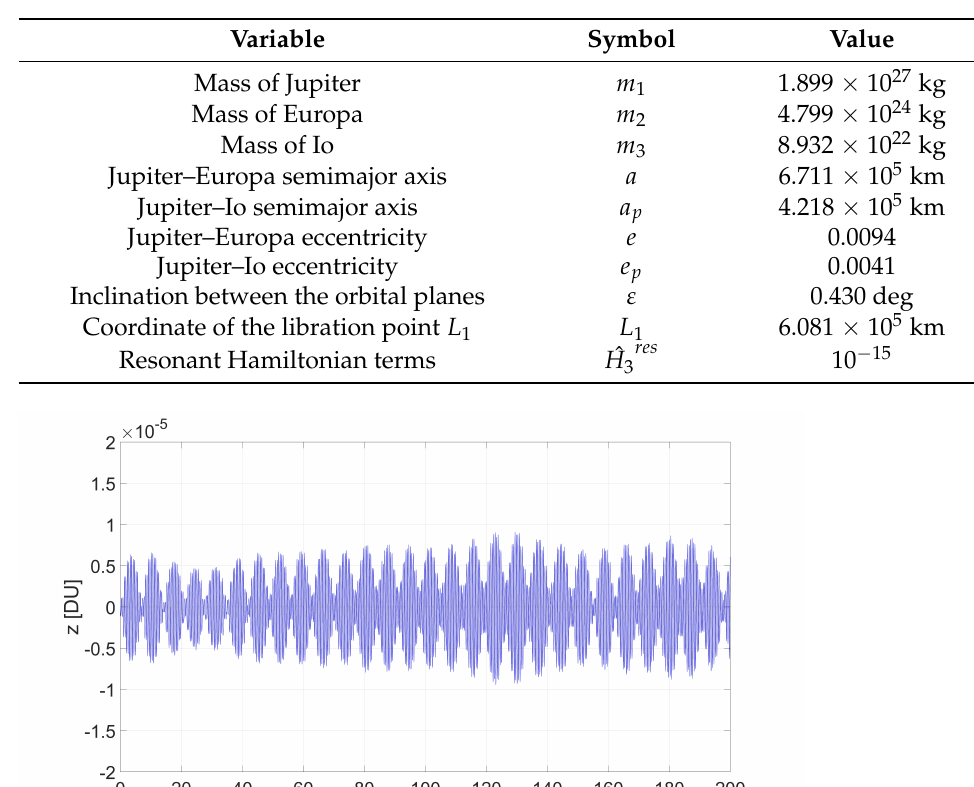
Table 1. Parameters of the Jupiter–Europa–Io system.